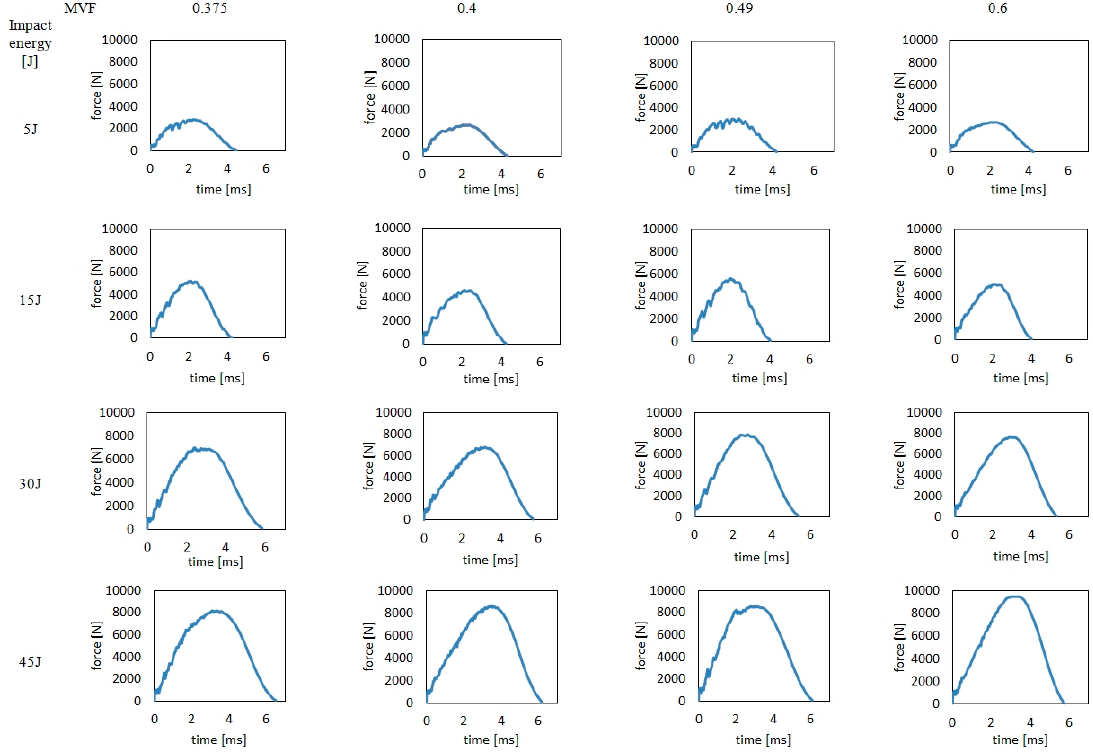
Figure 2. The force–time curves of HTCL with various metal volume fraction (MVF) after low-velocity